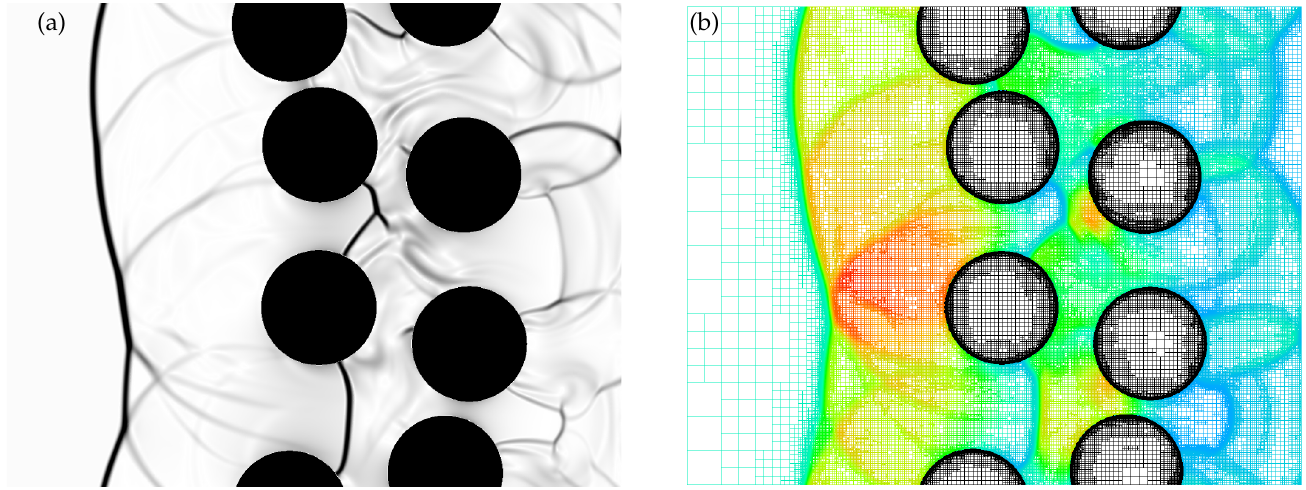
Figure 6. Numerical schlieren image ( a ) and the adaptive grid colored by the pressure field ( b ) for supersonic flow past an array of